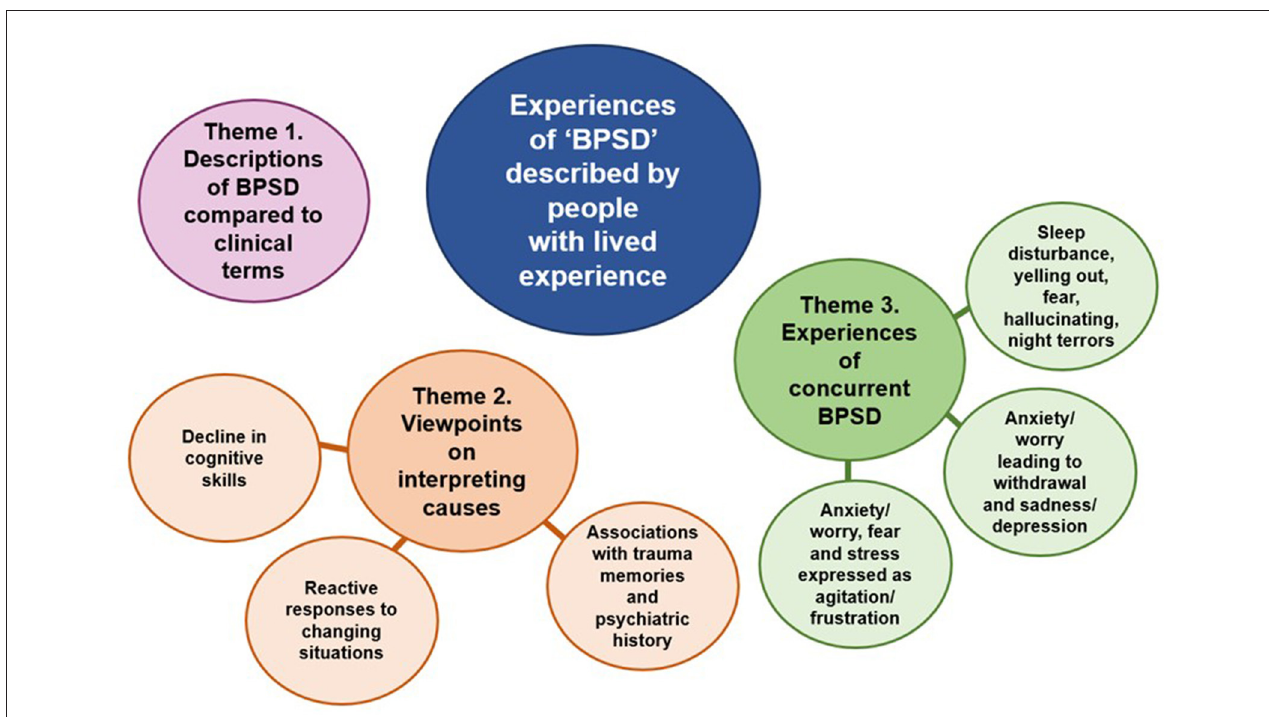
FIGURE 1 | Summary of main themes and subthemes that emerged relating to the aims of this